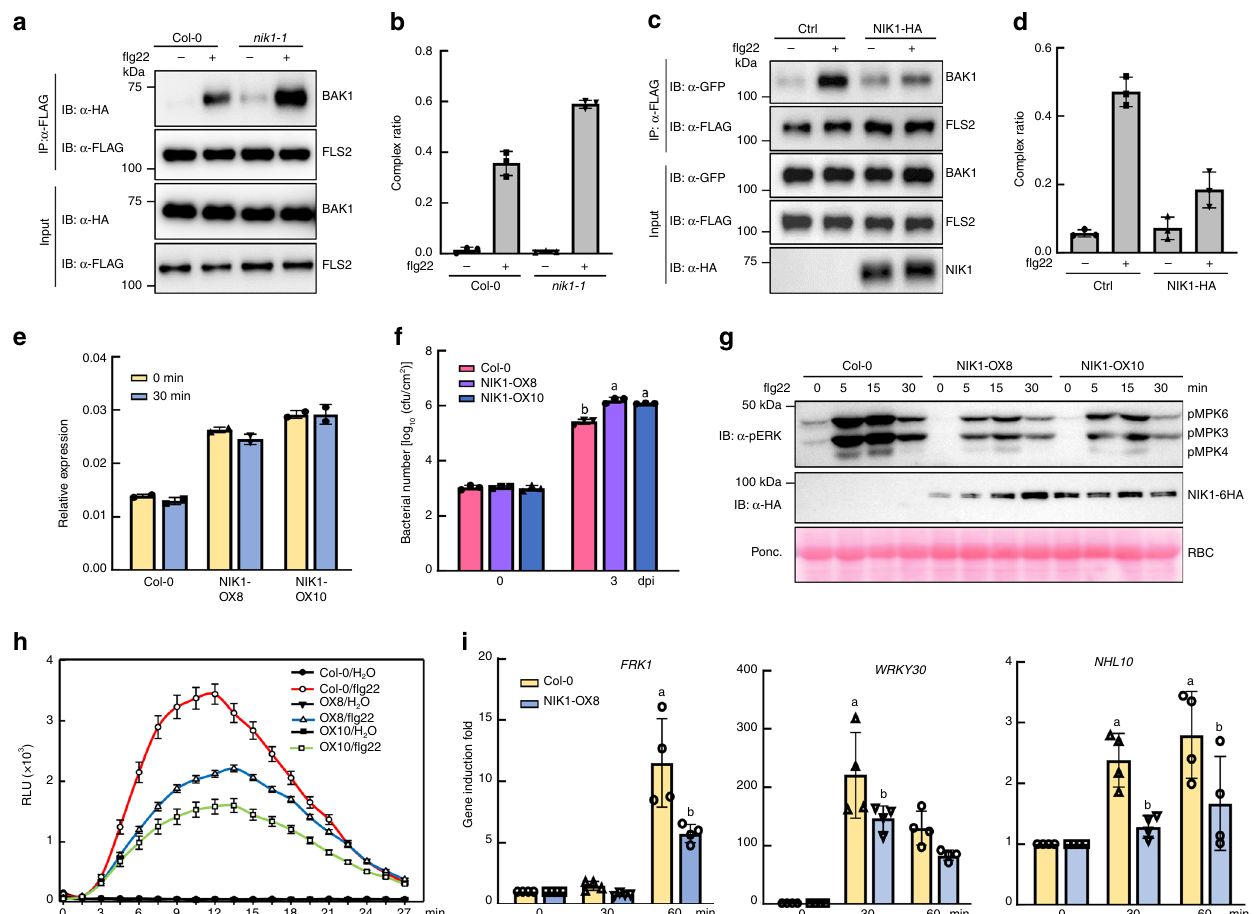
Fig. 4 NIK1 negatively modulates the fl g22-induced FLS2/BAK1 complex formation. a Flg22-induced FLS2 and BAK1 interaction is reinforced in nik1-1 mutants. BAK1-HA and FLS2-FLAG were co-expressed in Col-0 or nik1-1 mutant protoplasts, and samples were treated with fl g22 for 10 min before Co-IP was performed. b Quantitative data for a . Co-IP images were quanti fi ed using the ImageJ software, and values represent the mean ± SD ( n = 3). c Overexpression of NIK1 impairs FLS2/BAK1 immune complex formation. BAK-GFP and FLS2-FLAG were co-expressed with or without NIK1-HA in Col-0 protoplasts; protoplasts were treated with fl g22 before Co-IP was performed. Immunoprecipitation was carried out with an α -GFP antibody (IP: α -GFP), and the proteins were analysed using immunoblots with α -FLAG, α -GFP or α -HA antibodies. d Quantitative data for c . Co-IP images were quanti fi ed using the ImageJ software, and values represent the mean ± SD ( n = 3). e NIK1 expression level in WT and overexpression lines. Total RNA was isolated from Col-0 and overexpression lines and the expression of NIK1 was monitored by qRT-PCR. f Pst DC3000 bacterial growth in WT and NIK1 -OX lines. Four-week-old plants were hand-inoculated with pathogens, and bacterial populations were monitored at 0 and 3 dpi. Different letters denote signi fi cant differences among bacterial number of distinct genotypes by the one-way ANOVA test ( n = 3, p < 0.05). g Flg22-induced MAPK activation in Col-0 and NIK1 -OX lines. Ten-day-old seedlings from half MS plates were treated with fl g22 and MAPK activation was monitored with an α -pERK antibody. h ROS burst is suppressed in NIK1 -overexpressing transgenic lines. Leaf discs from soil grown plants were treated with water or 100 nM fl g22 for 30 min, and RLU was measured. i qPCR analysis of PTI early response genes induction in NIK1 -overexpressing plants. Ten-day-old seedlings were treated with fl g22 for 30 and 60 min, and total RNA was extracted for qRT-PCR analysis. Values represent the mean ± SE of three biological replicates. Different letters denote signi fi cant differences by the one-way ANOVA test ( n = 3, p < 0.05). Source data are provided as a Source Data fi